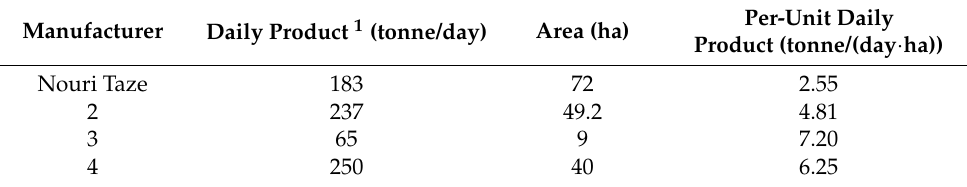
Table 8. Iranian glass container manufacturer